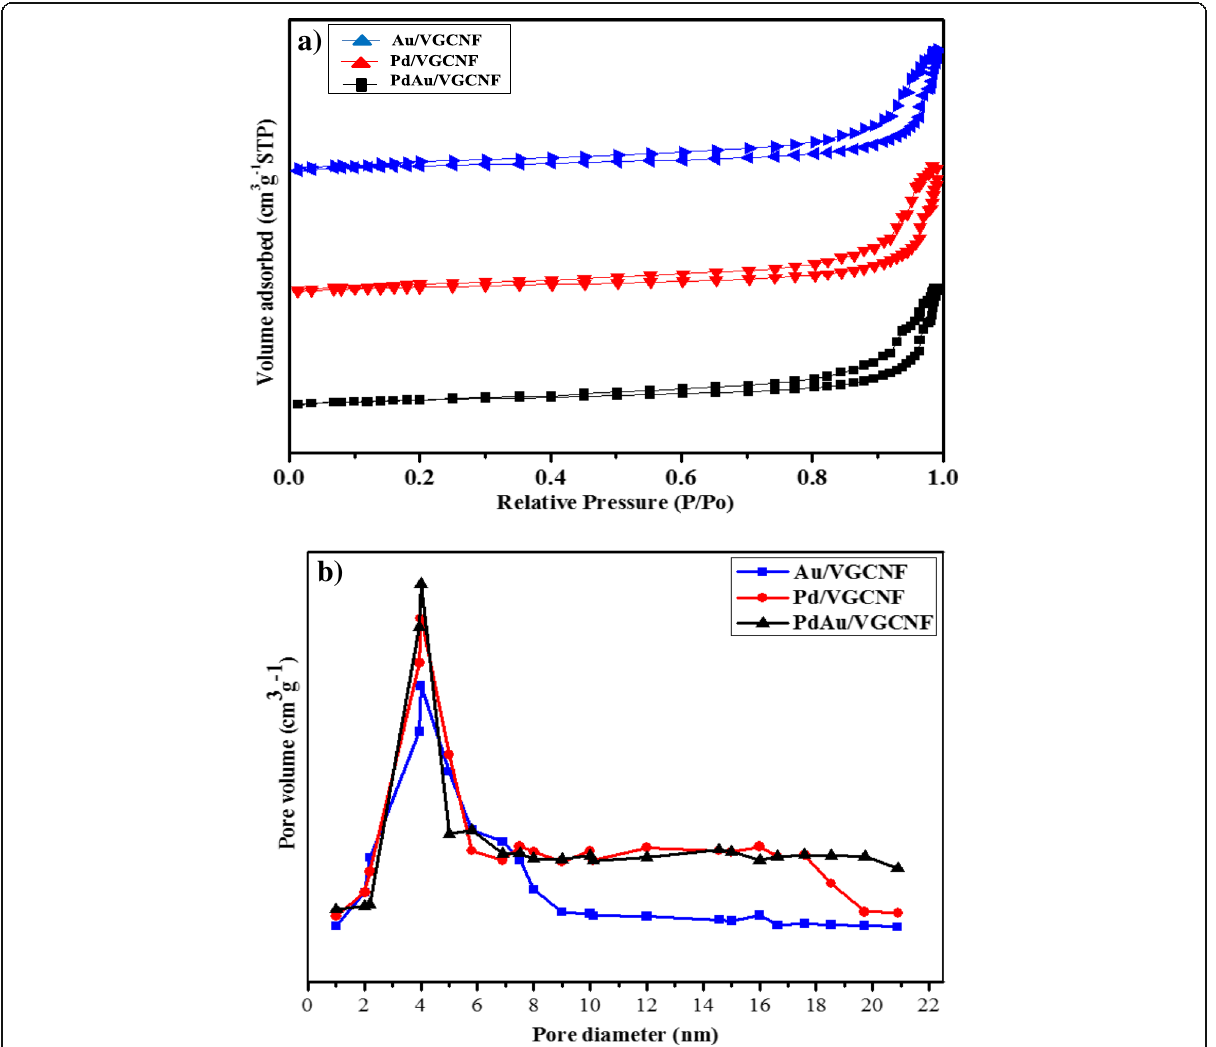
Fig. 3 a N 2 adsorption/desorption isotherms of Au/VGCNF, Pd/VGCNF, and Pd 1 Au 1 /VGCNF. b Pore size distribution curve of Au/VGCNF, Pd/ VGCNF, and